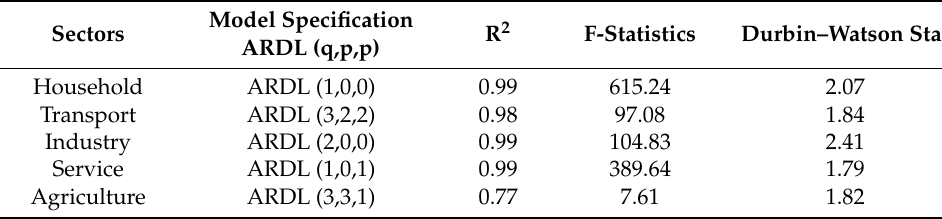
Table 16. The results for econometric analysis for different